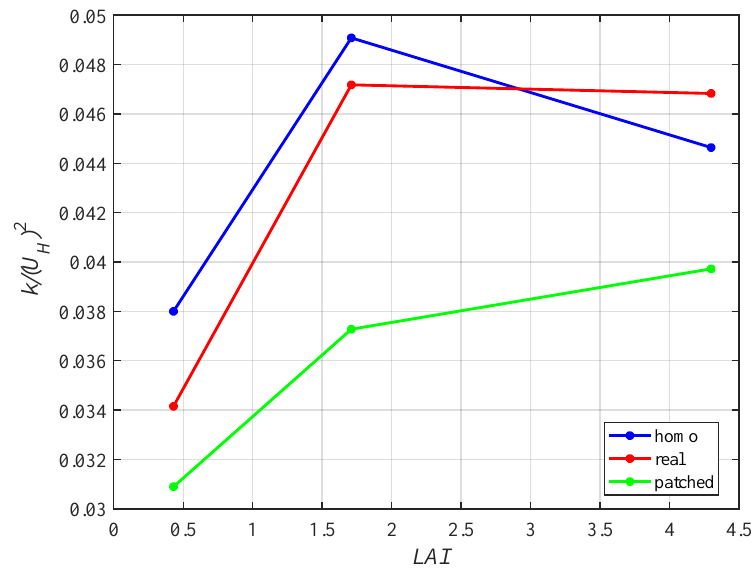
Figure 17. TKE vs. LAI at hub height for respective heterogeneity